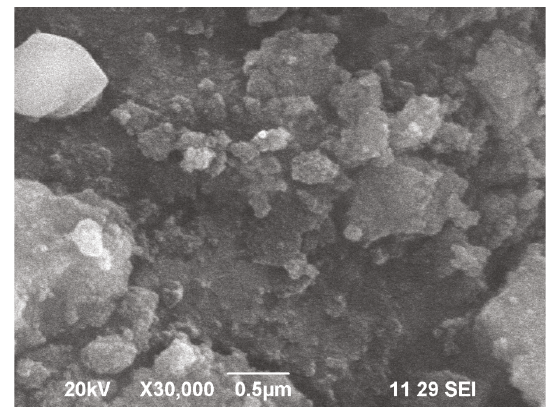
Figure 2: SEM image of CSSC.